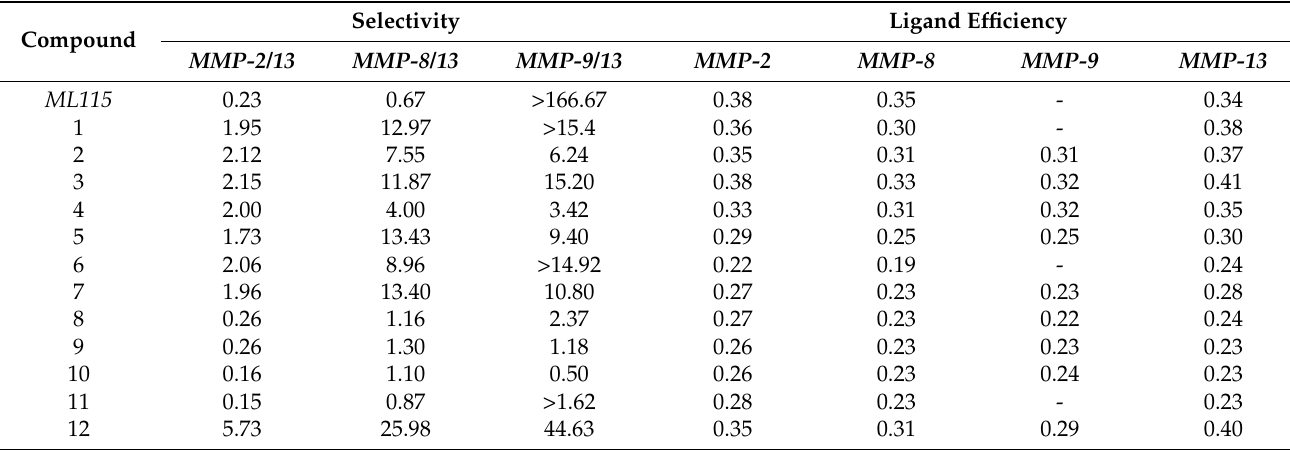
Table 3. Selectivity and ligand efficiency calculated on the basis of the IC 50 values of Table